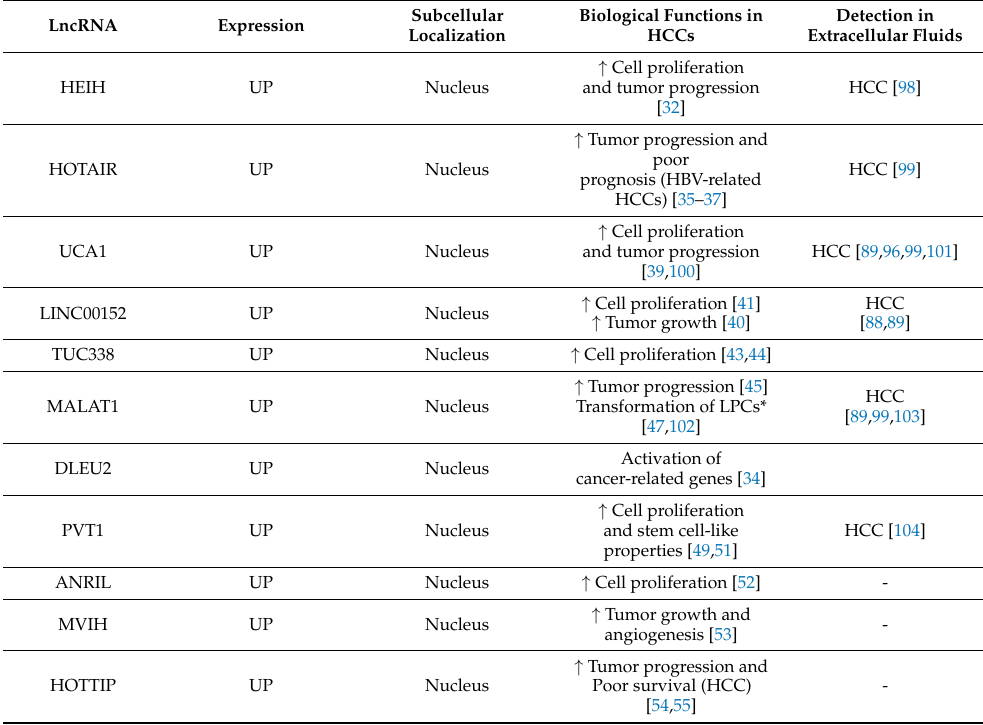
Figure 3. LncRNA involved in the development and progression of HBV-related HCCs. The biological functions targeted by lncRNAs deregulated in HBV-related HCCs and involved in HCC development and progression are shown. The lncRNA are grouped according to their up- or downregulation in the tumor and their activity in the nucleus or in the cytoplasm. Table 1. LncRNAs deregulated in HBV-related